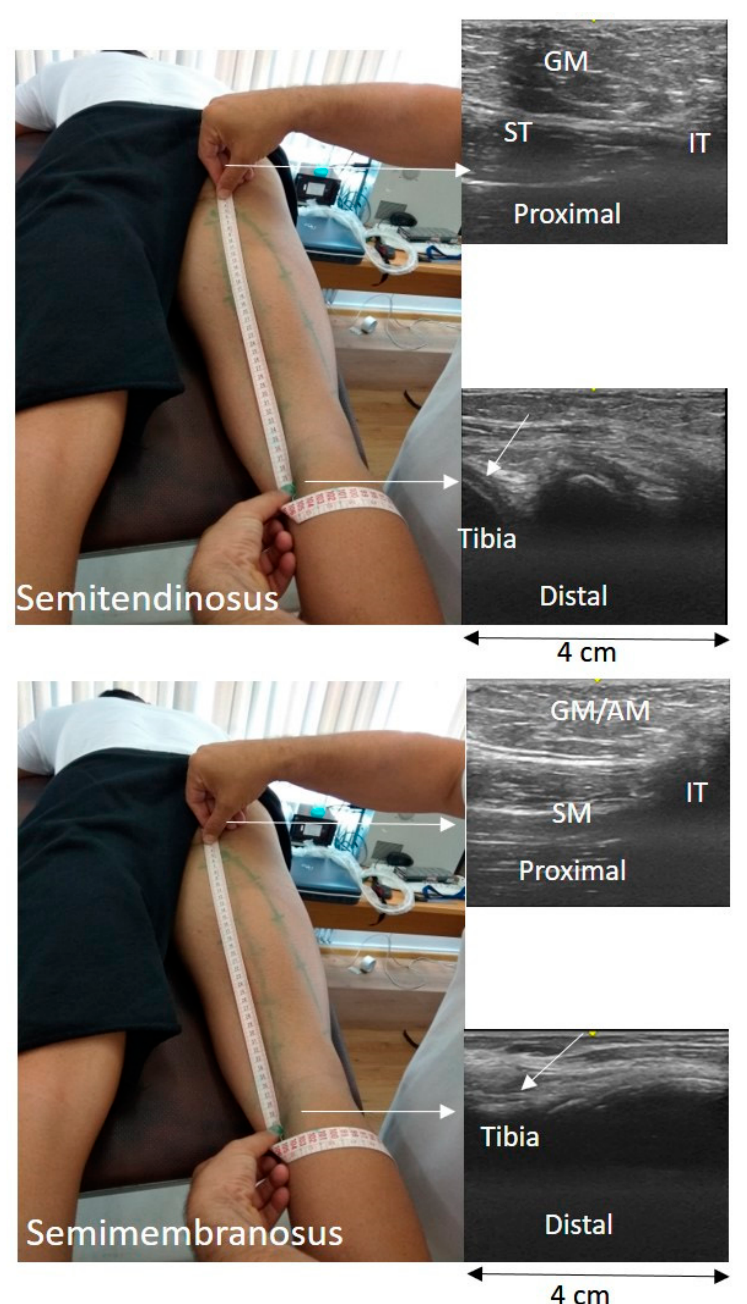
Figure 2. Measurement of muscle-tendon unit length using the tape-ultrasound (TAPE-US) technique. In each testing position, the distal origin and proximal ends of the biceps femoris long head (BFlh), semitendinosus (ST), and semimembranosus (SM) were first identified and marked on the skin (arrows indicate tendon origin). The path of the muscle-tendon unit was drawn on the skin surface with the assistance of US images obtained as the probe moved slowly from the proximal to the distal end. Subsequently, the distance between the two ends was measured using a tape measure (GM = gluteus maximus, AM = adductor magnus, and IT = ischial tuberosity).